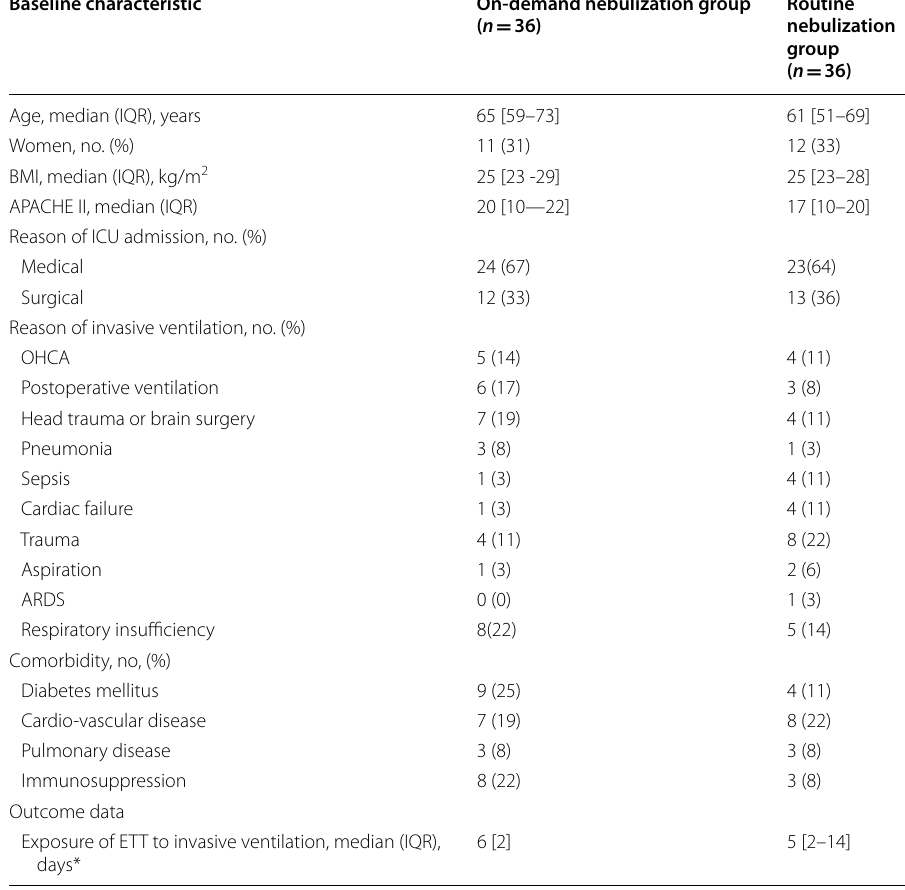
Table 1 Baseline characteristics, and main outcome of patients receiving on-demand nebulizations vs. routine nebulizations